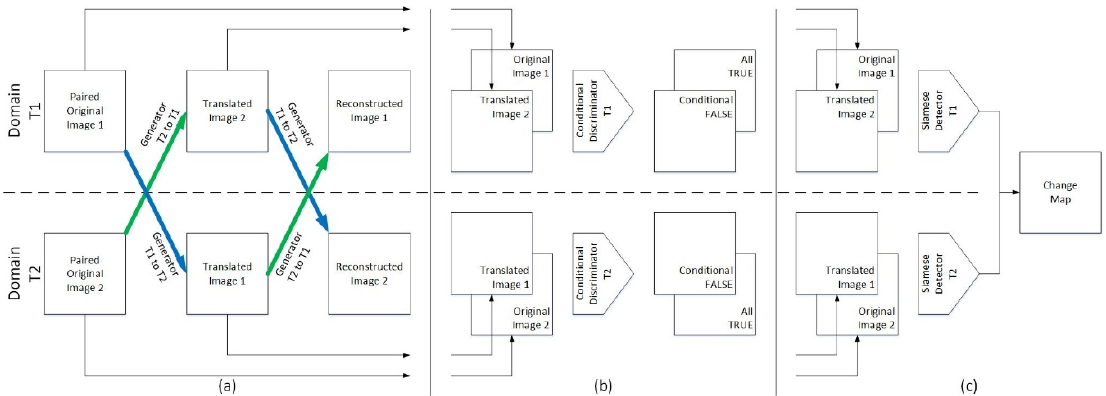
Figure 1. Framework of the proposed method for change detection using bi-temporal very-high-resolution (VHR) optical remote sensing images: ( a ) mapping generation, ( b ) conditional discrimination, ( c ) Siamese detection, ( a ) + ( b ) domain transfer stream, ( a ) + ( c ) change decision stream.